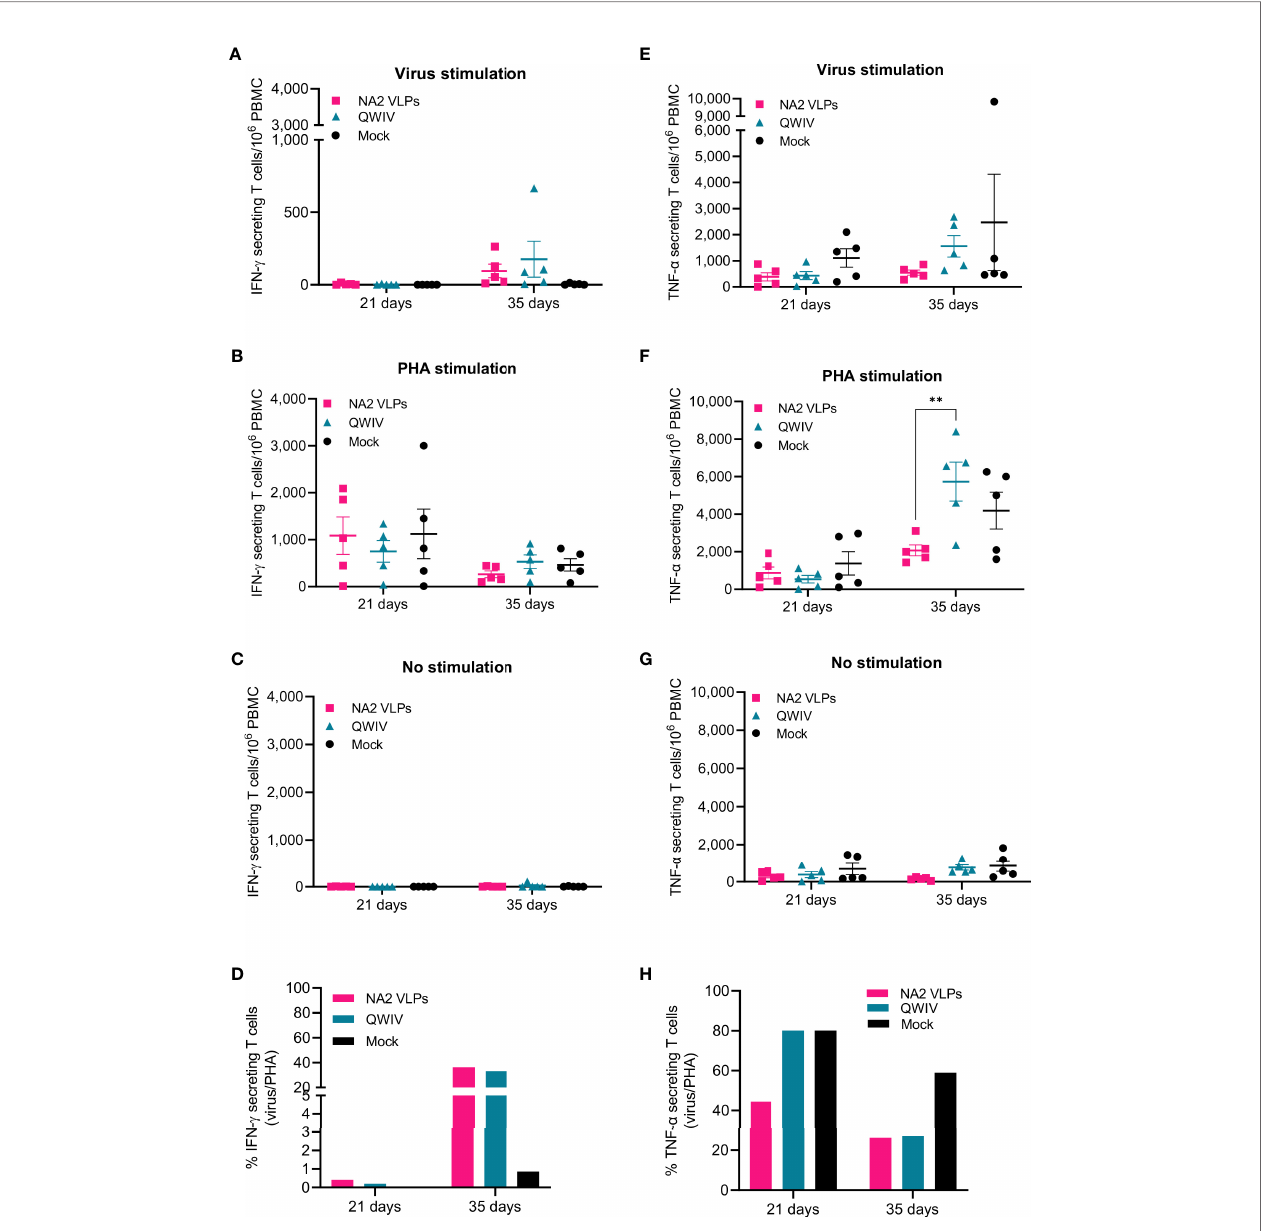
FIGURE 4 | Vaccination with NA2 VLPS decreases TNF- a secreting T cells compared to mock vaccination following infection with A/swine/NC/KH1552516/2016 virus. PBMCs from pigs vaccinated in a prime-boost regimen 21 days apart with a QWIV, NA2 VLPs, or mock vaccinated with water-in-oil-in-water adjuvant were collected at 21 and 35 days and re-stimulated with A/swine/NC/KH1552516/2016 virus or PHA for enumeration of cytokine secreting cells. They were tested for IFN- g secreting cells following (A) virus re-stimulation. (B) PHA re-stimulation. (C) no stimulation (D) ratio of virus vs PHA stimulated cells They were tested for TNF- a secreting cells following (E) virus re-stimulation. (F) PHA re-stimulation. (G) no stimulation (H) ratio of virus vs PHA stimulated cells. Pink squares represent NA VLP vaccinated pigs, cyan triangkes represent commercial quadrivalent whole inactivated virus vaccinated pigs (QWIV), and black circles represent mock vaccinated pigs. Horizontal lines represent the mean for each group. Statistical analysis was performed by two-way ANOVA test. Error bars represent SEM. ** = p <